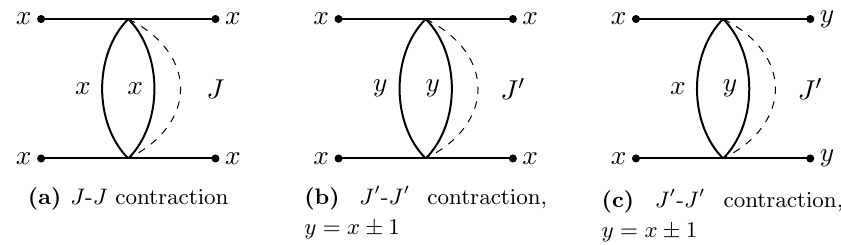
Figure 12. Three types of the \rungs": type (a) is the same as the one appears in SYK, induced by the interactions between fermions at same sites; type (b) comes from the interactions between fermions at site x and nearest neighbor y = x (cid:6) 1, but the \rails" carry the same site indices, therefore, the e(cid:11)ect of interaction doesn’t propagate to next site; type (c) also comes from the interactions between nearest neighbor sites, and the rails get shifted by (cid:6)